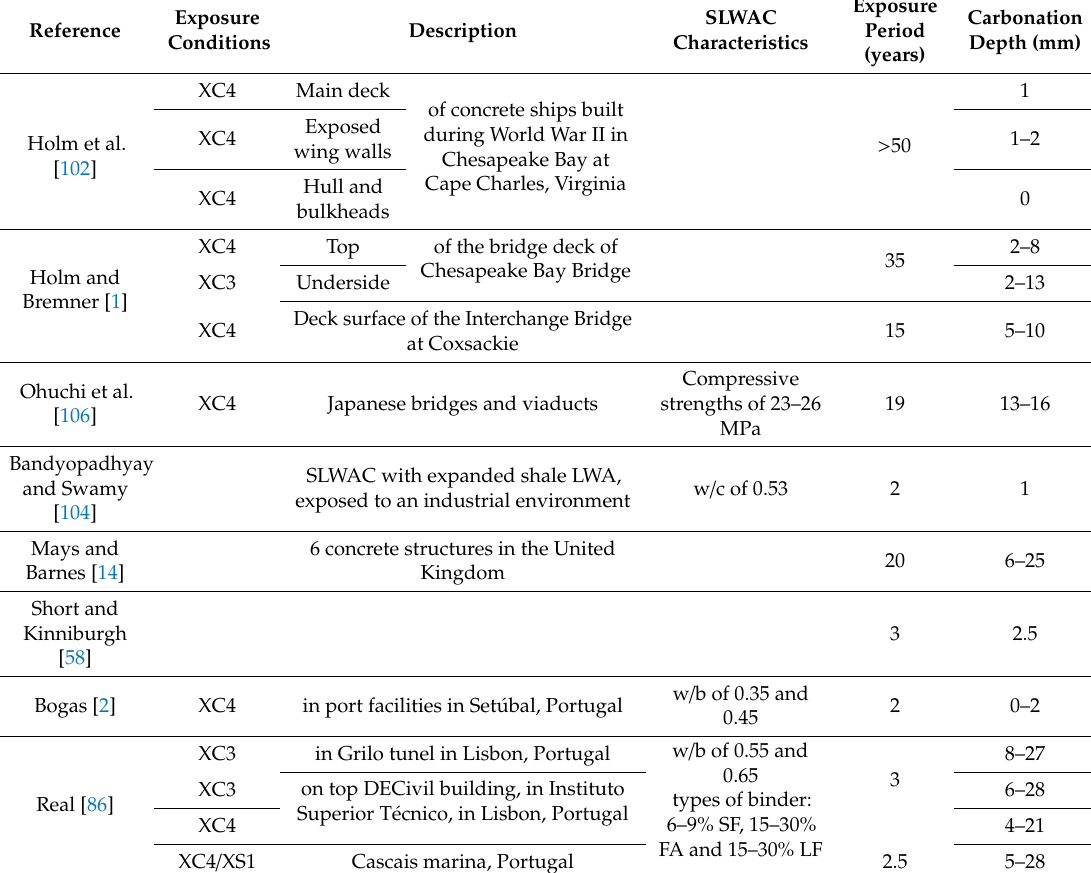
Table 2. Carbonation depths of SLWAC exposed to natural